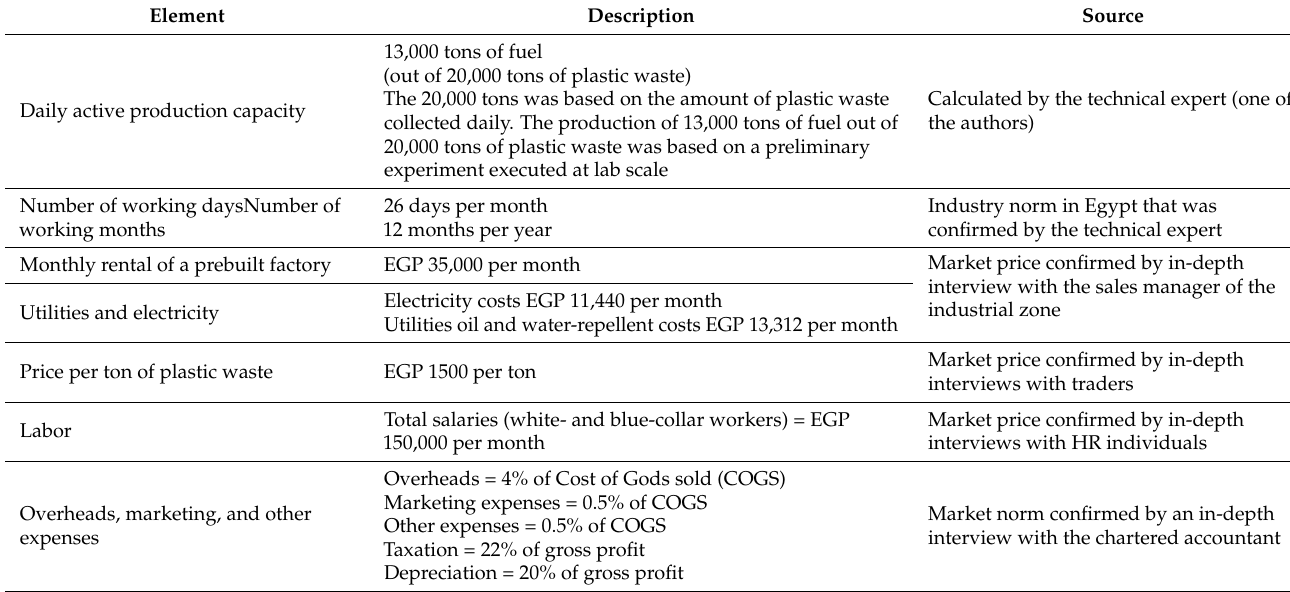
Table 5. Key assumptions for the feasibility